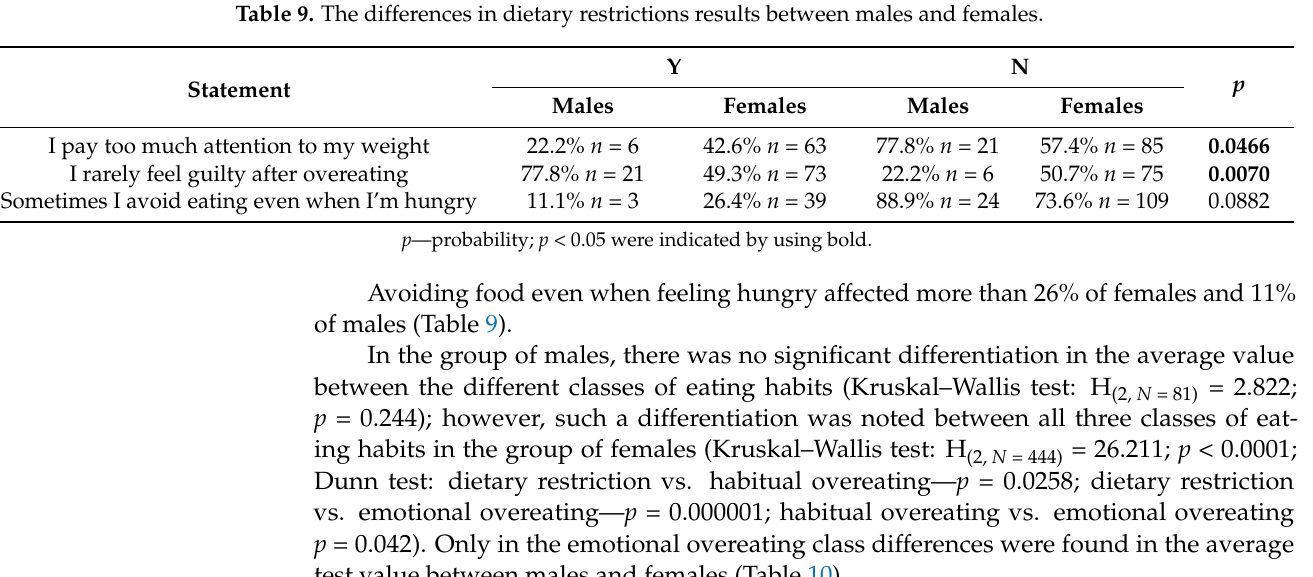
Table 10. The mean and standard deviation (SD) values for different classes of eating habits in males and females. Factor